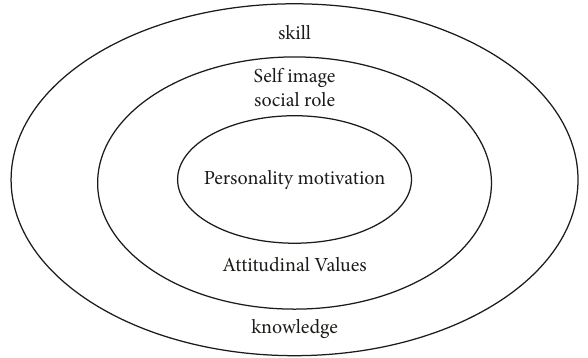
Figure 3: The onion model of